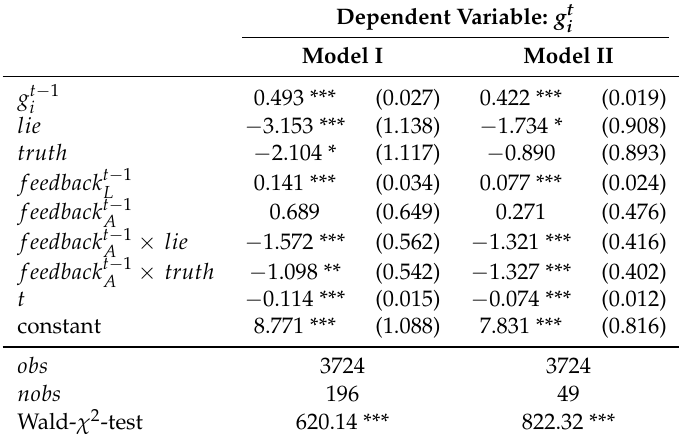
Table 1. Estimation results for a Tobit regression with individual random effects (model I) and a level two mixed-effect maximum likelihood estimation with group fixed effects and individual random effects (model II) with dependent variable g t ; coefficients are reported along standard errors in i parenthesis; *** indicates significance at a p < 0.01 level, ** at a p < 0.05 level and * at a p < 0.1